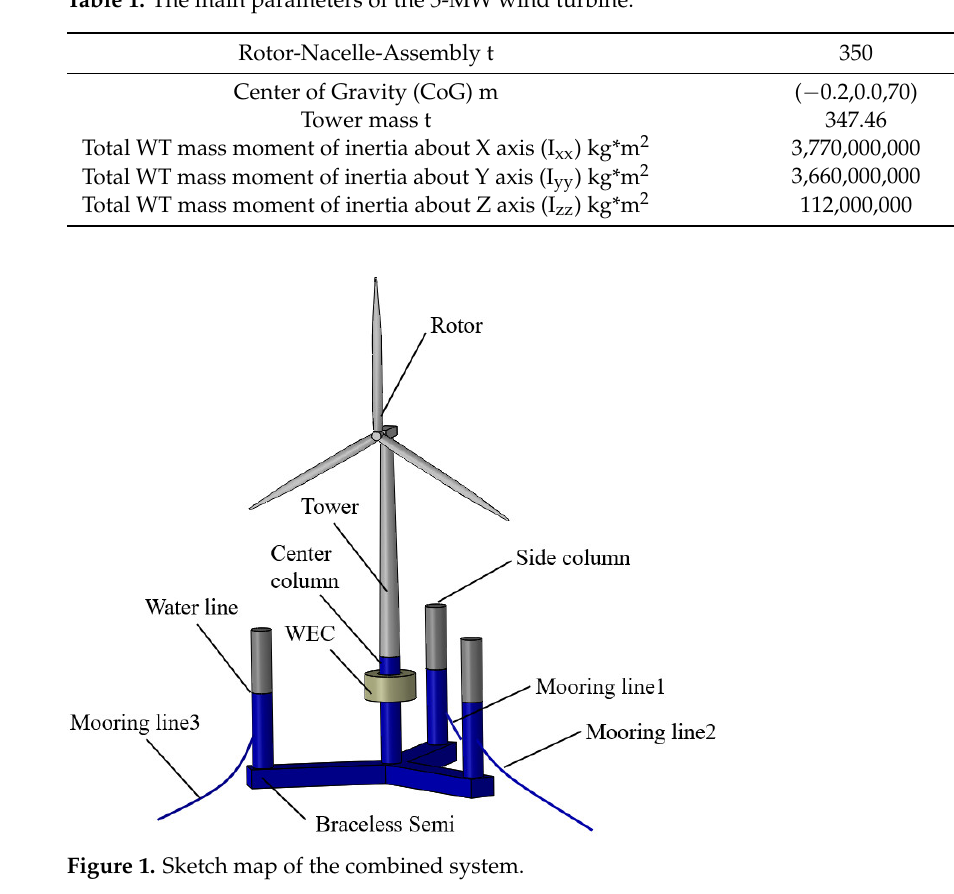
Figure 2. Panel models for the hydrodynamic analysis. Table 2. The main parameters of the combined system. Parameters